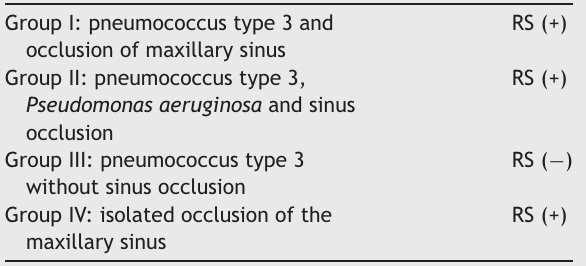
Incidence of rhinosinusitis in the groups of the study by Dufour et al.